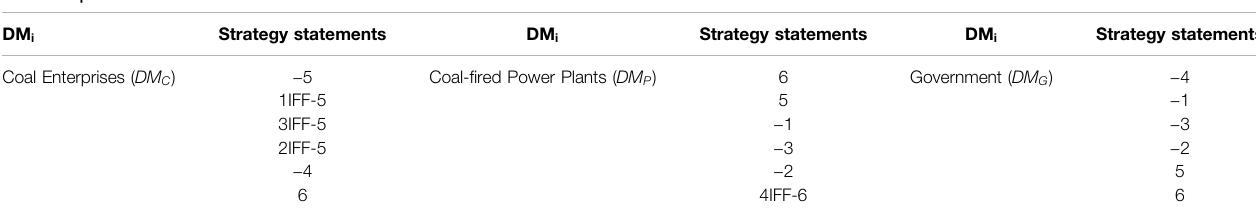
TABLE 4 | Preference statement of feasible con fl ict